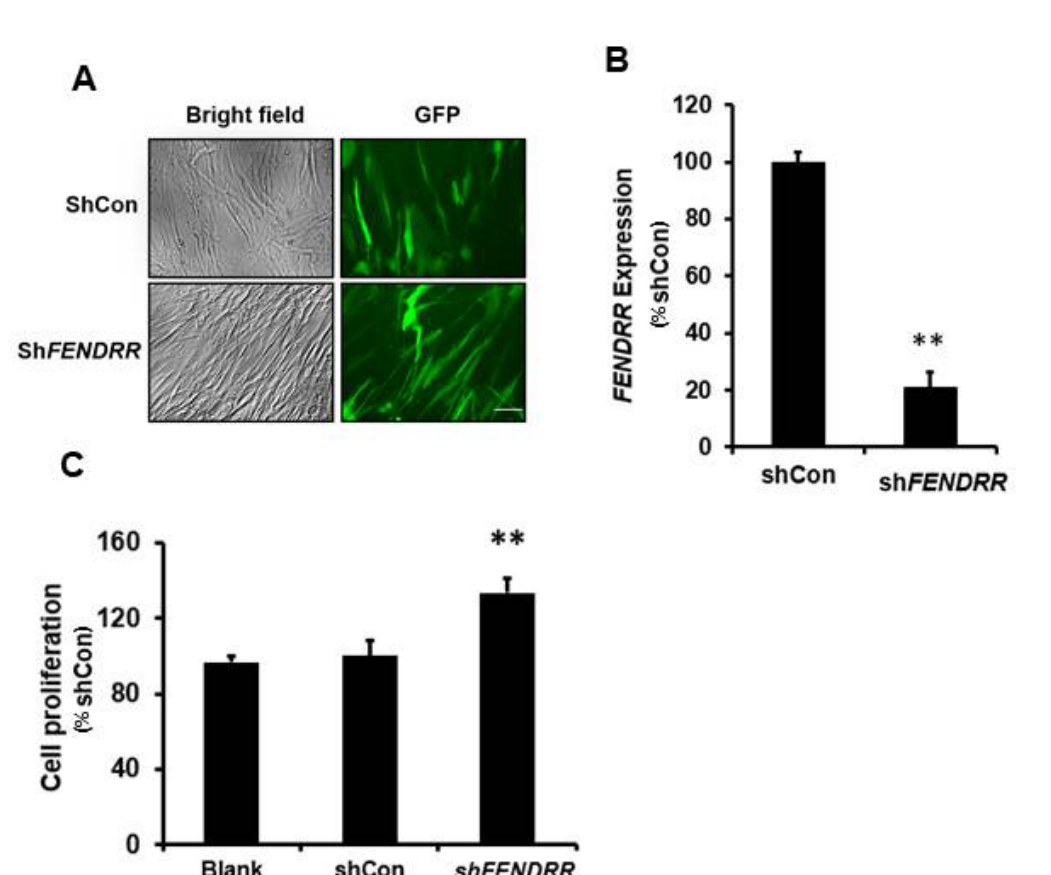
Figure 2. FENDRR silencing increases lung fibroblast proliferation. ( A ) Bright-field and GFP images of HPF cells infected with FENDRR shRNA (sh FENDRR ) or shRNA control (shCon) lentiviruses (MOI 100 for 24 h). Scale bar: 100 µ m. ( B ) Real-time PCR determination of FENDRR expression in HPF cells infected with sh FENDRR or shCon. FENDRR expression was normalized to β -actin and expressed as %shCon. ( C ) Cell proliferation was determined by the BrdU assay in blank cells and the cells infected with shCon and sh FENDRR after 6 days of culture. The results were expressed as %shCon. Values represent the means ± SE. n = 3 independent experiments. ** p < 0.01 vs shCon. Student’s t-test for ( B ) and one-way ANOVA and Tukey’s multiple comparison for ( C ) .